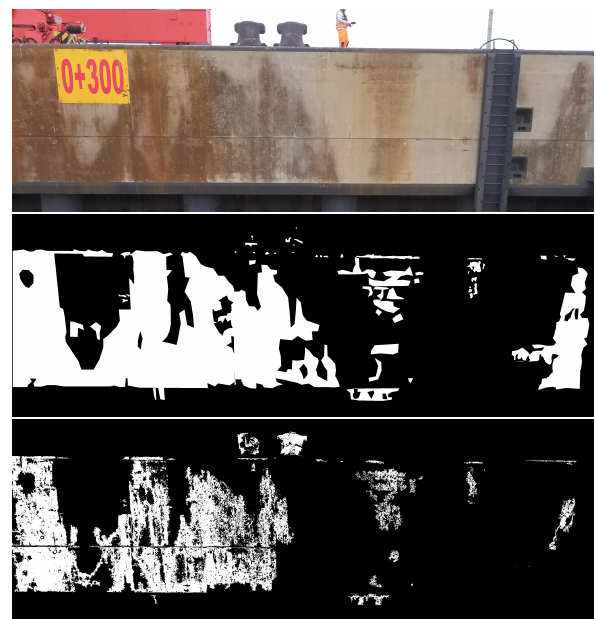
Figure 1. Example of a cropped RGB image showing the east-facing sheet pile wall of the JadeWeserPort and corresponding weakly and manually supervised ground truth images (top to